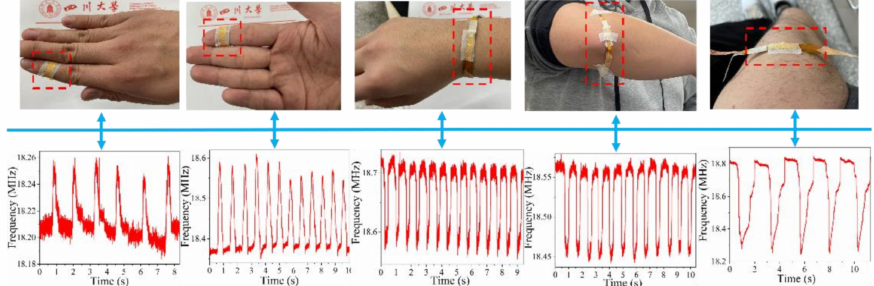
Figure 12. Measurement positions on the human body and the corresponding detection signals. From left to right: outside and inside of finger joints, wrist, elbow joint, and knee